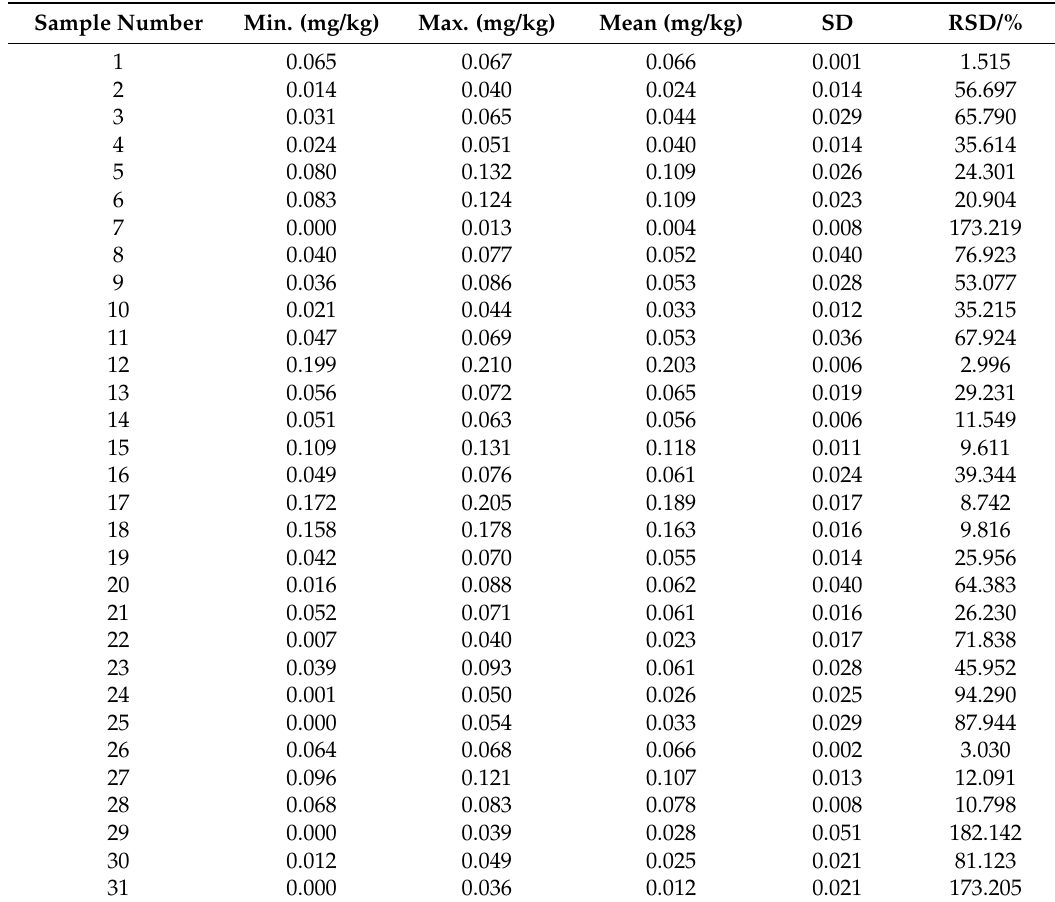
Table 4. Detection results of cadmium concentration in rice grain samples by